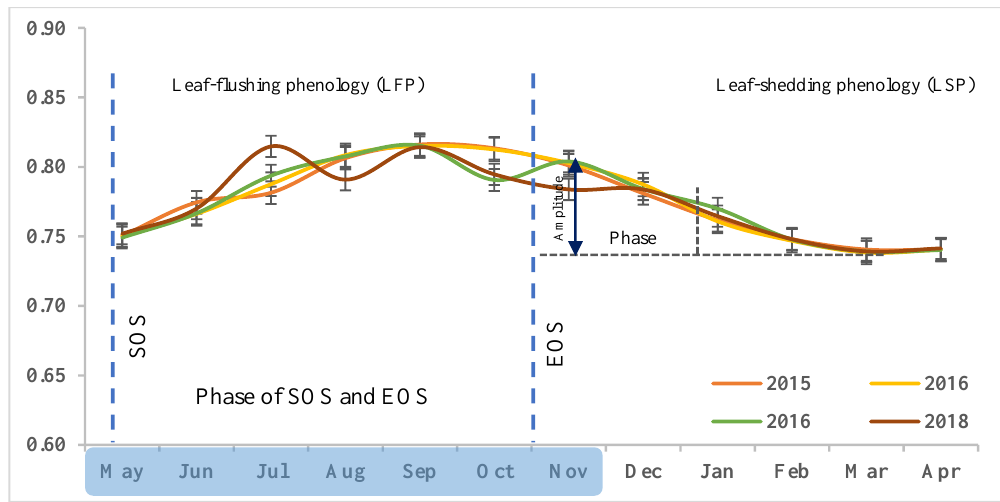
Figure 7. Fitted mean vegetation index profiles of Landsat 8 OLI EVI composite data for rubber plantation. Average index profiles were generated by assessing 40 profiles from 10 geometry locations of the bamboo category between 2015 and 2018.